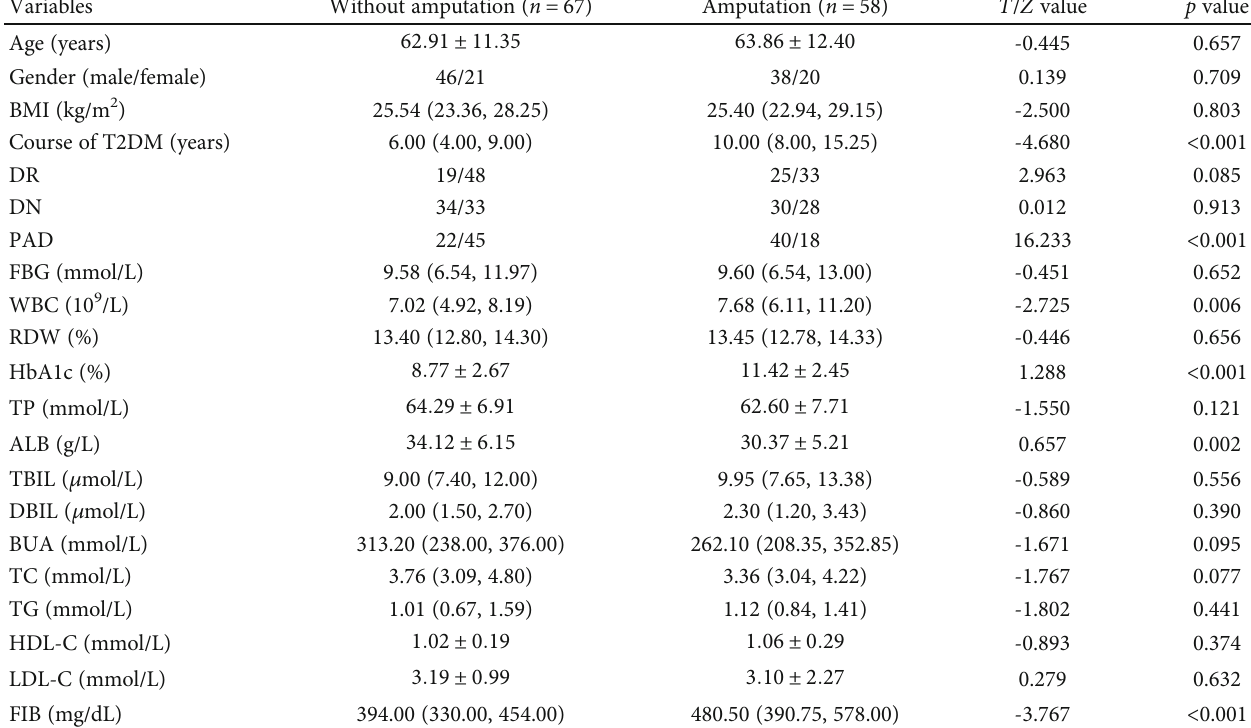
Table 1: Di ff erences in characteristics between the without amputation group and the amputation group.